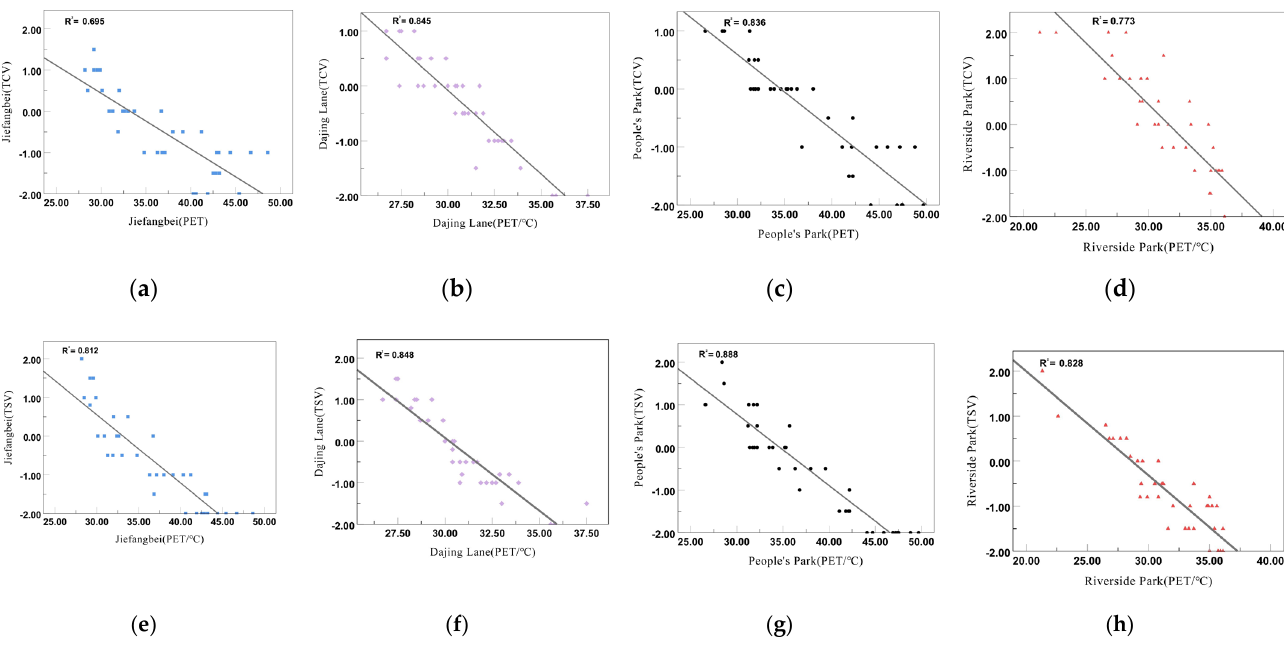
Figure 7. Analysis of the mean thermal sensory vote (TSV) and mean thermal comfort vote (TCV) and PET fit for each measurement area: ( a ) Jiefangbei (TCV); ( b ) Dajing Lane (TCV); ( c ) People’s Park (TCV); ( d ) Riverside Park (TCV); ( e ) Jiefangbei (TSV); ( f ) Dajing Lane (TSV) ( g ) People’s Park (TSV); ( h ) Riverside Park (TSV).